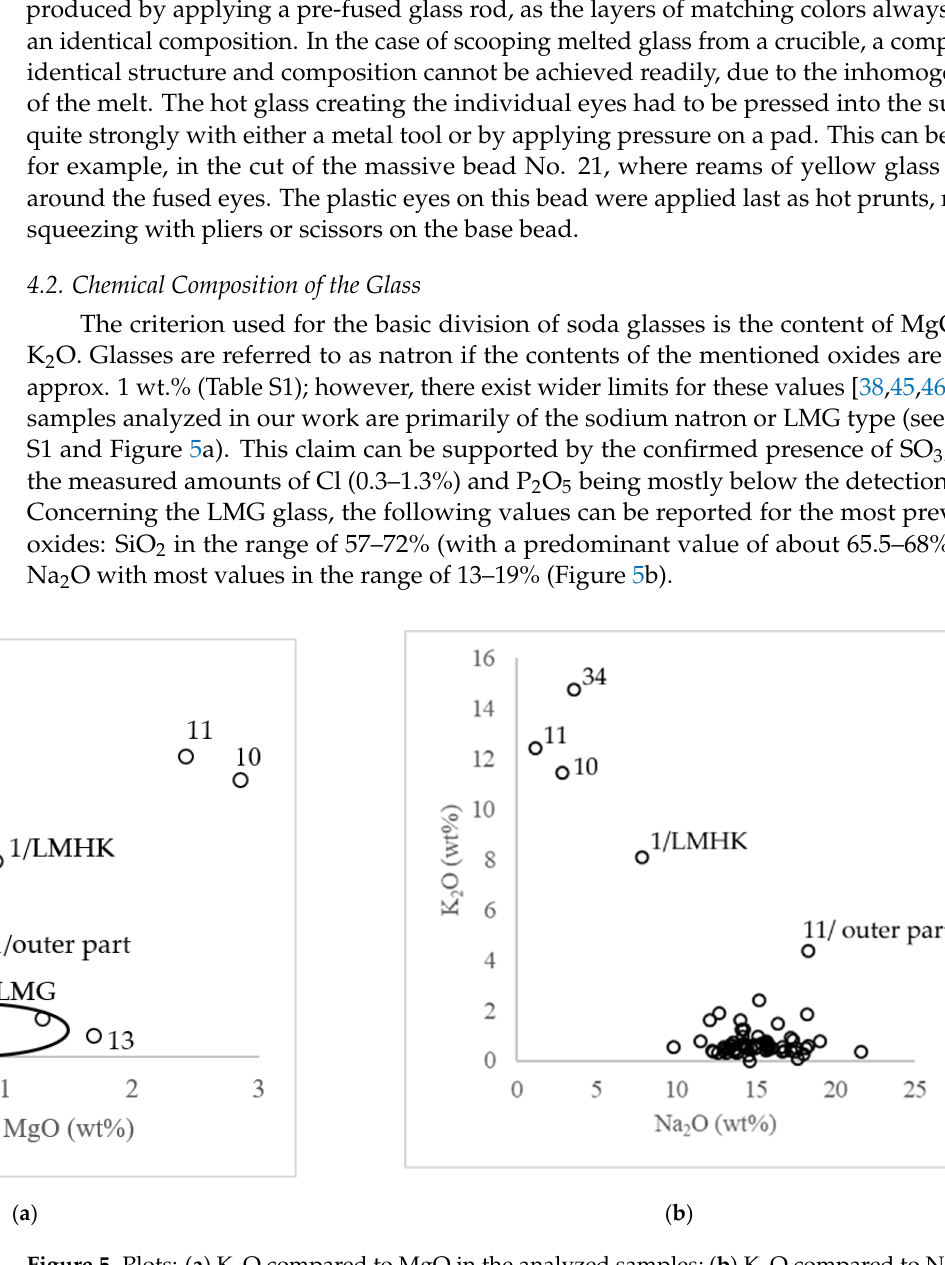
Figure 5. Plots: ( a ) K 2 O compared to MgO in the analyzed samples; ( b ) K 2 O compared to Na 2 O in analyzed samples.